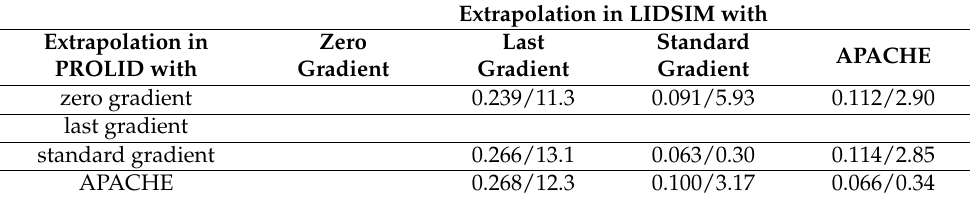
Table 2. The standard deviation and the absolute maximum of the difference on the mole fraction of methane to dry air averaged over the atmospheric column in ppb according to the extrapolation methods used by LIDSIM and by PROLID. The mean is in all cases the same and its value of 0.08 ppb can be attributed to factors other than the meteorological data. The simulation is for a complete